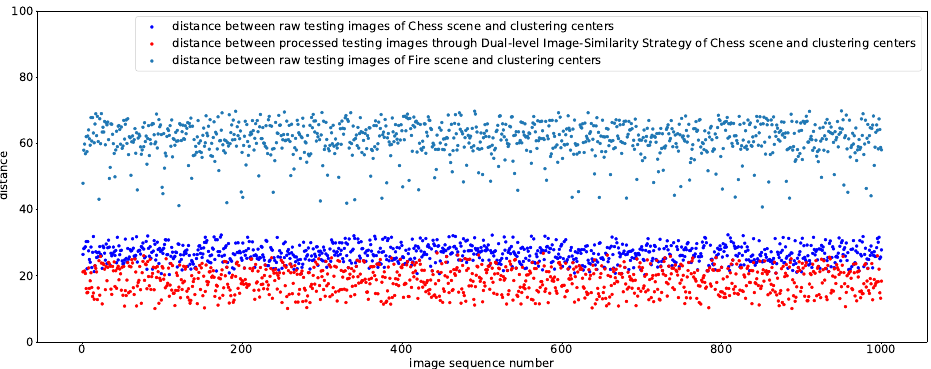
Figure 8. The distance between feature vectors of three types of testing images and clustering centers of the training images in Chess scene.